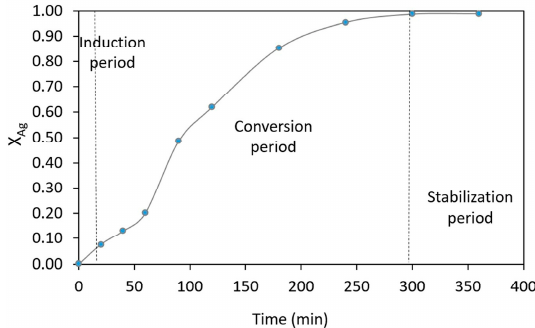
Figure 5. Dissolution curve of Ag in the S 2 O 32 − ‐ O 2 ‐ NaOH system. V = 0.5 L, Mineral = 40 g ∙ L − 1 , P O2 = 1 atm, pH = 9, t r = 360 min, d =74 μ m, [S 2 O 32 − ] = 0.5 mol ∙ L − 1 , [OH − ] = 0.1 mol ∙ L − 1 , T = 338 K, RPM = 670 min − 1 .